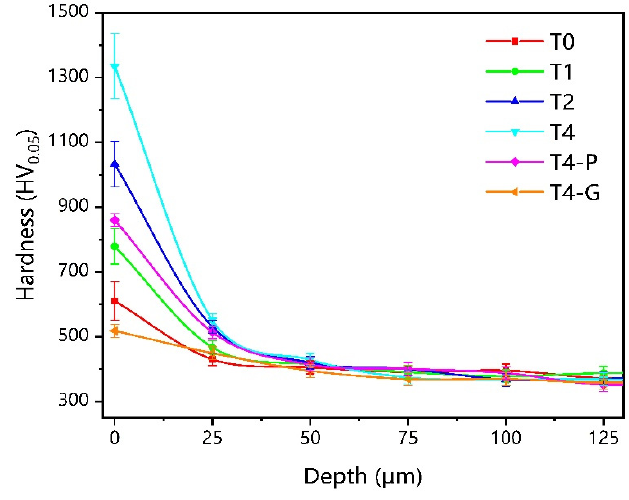
Figure 9. The cross-sectional hardness profile of different samples.